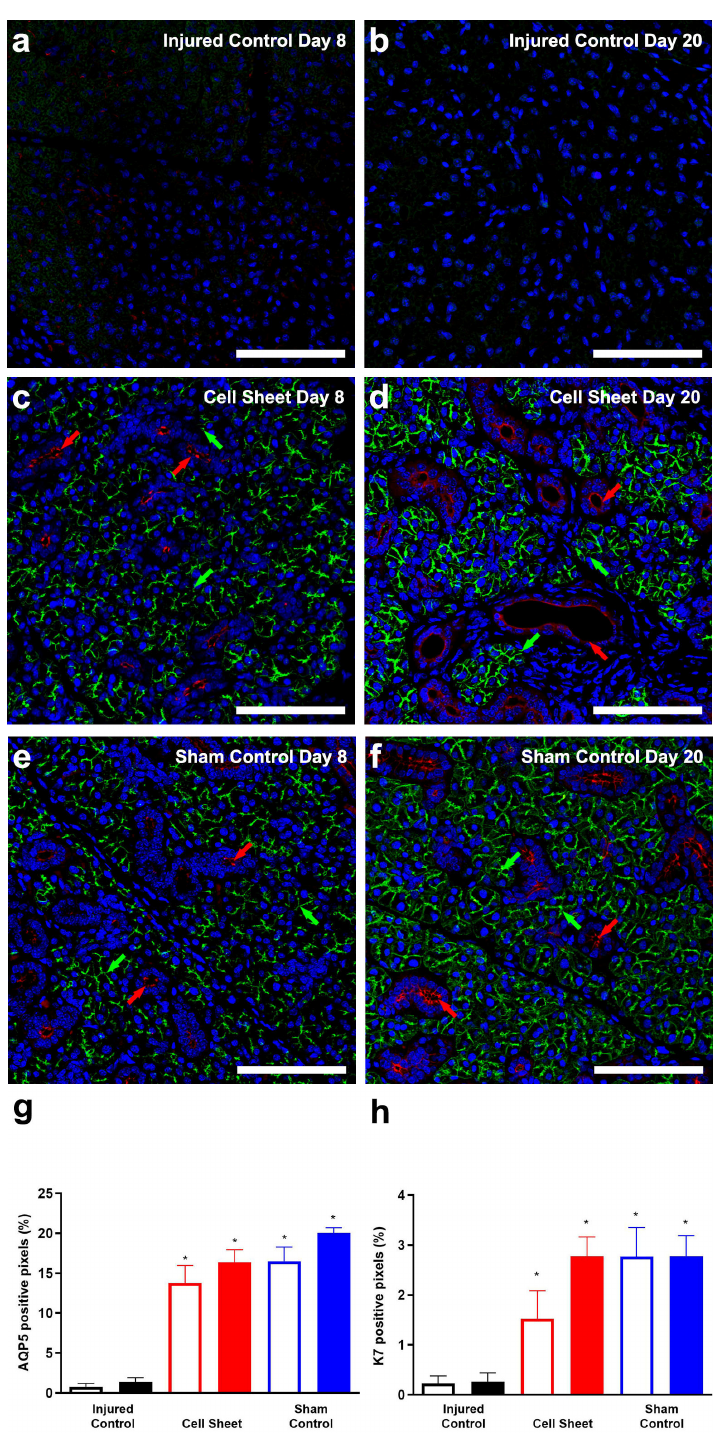
Figure 4. Cell sheets enhance expression of di ff erentiation markers: injured SMG ( a , b ); injured SMG treated with cell sheets ( c , d ); and sham controls ( e , f ). Tissue samples were incubated with rabbit anti-AQP5 ( a – f ) (green) and mouse anti-K7 ( a – f ) (red) antibodies and analyzed using a Zeiss LSM 700 confocal microscope, with data representing results from five experiments and white bars indicating 100 µ m. Positive areas of AQP5 ( g ) and K7 ( h ) fluorescence were captured using ImageJ software. Data are expressed as means ± SD of results from five independent experiments, where statistical significance was assessed by one-way ANOVA ( p < 0.05) and Dunnett’s post-hoc test for multiple comparisons to injured controls (open bars: Day 8; closed bars: Day 20); * significant di ff erence from injured controls. Green and red arrows indicate AQP5 and K7 expression,